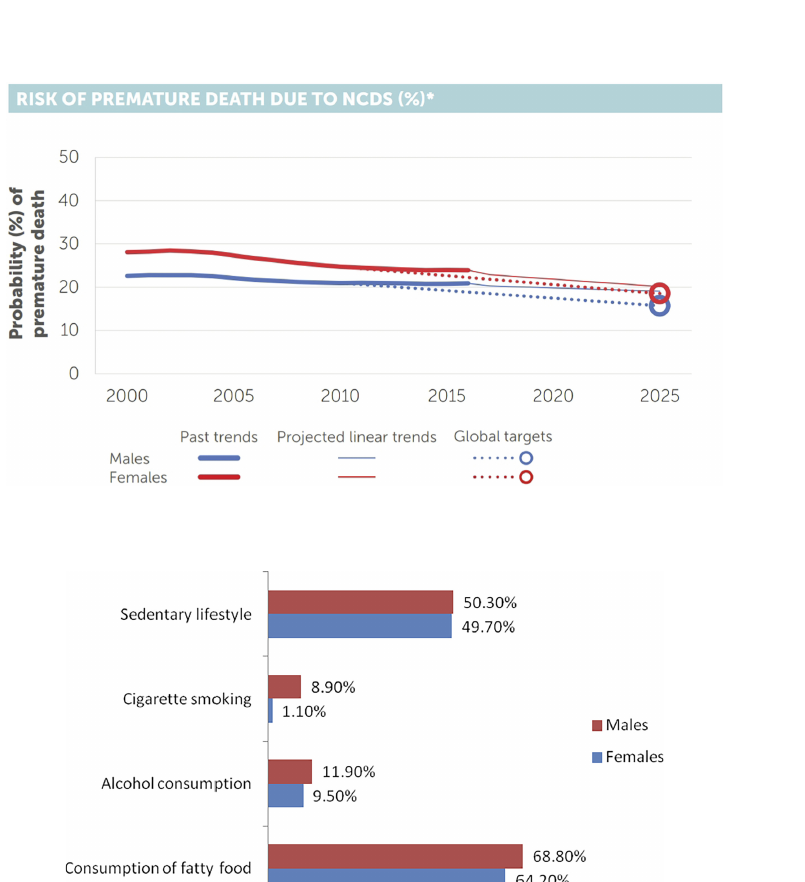
Figure 2. Proportional mortality